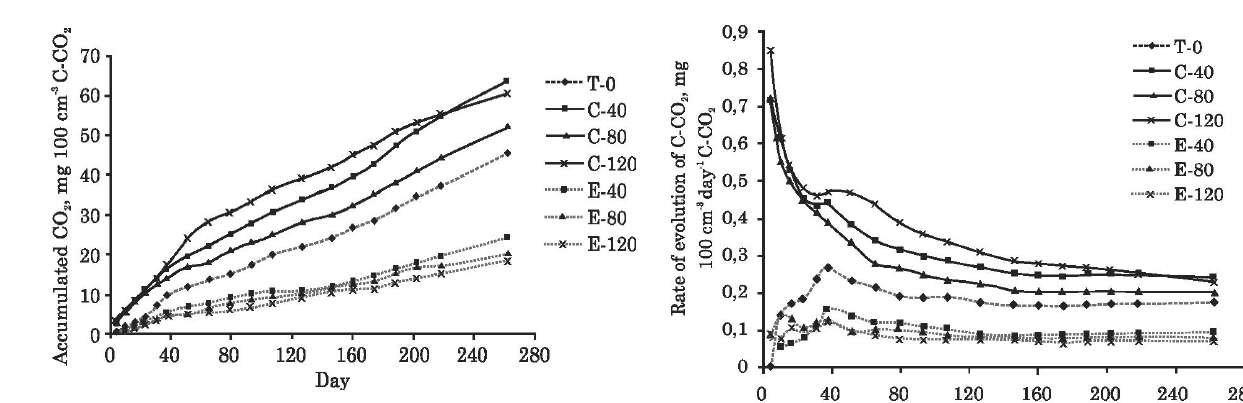
Figure 1. Accumulated CO 2 emission from columns treated with increasing doses of limestone and steel slag for 262 days.